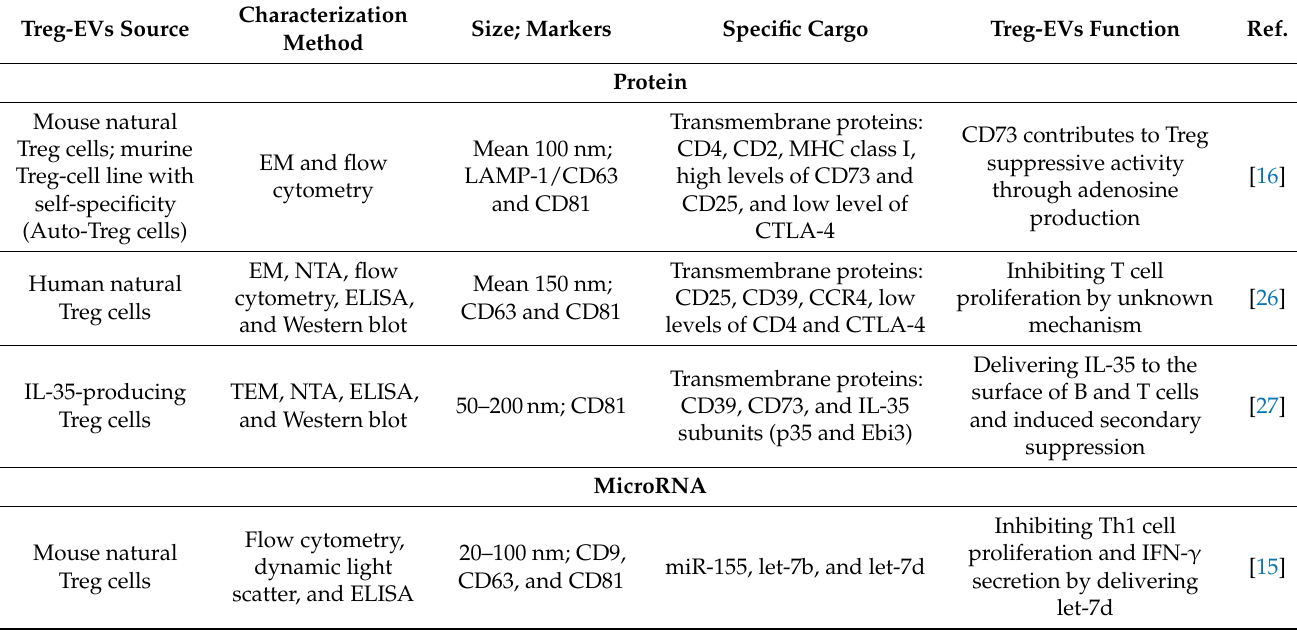
Table 1. Summary of specific cargo of Treg cells-derived extracellular